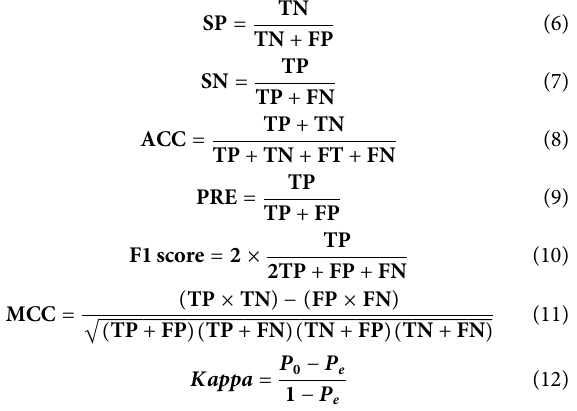
algorithm. LightGBM offers better model training accuracy and prevention of over fi tting than traditional classi fi cation